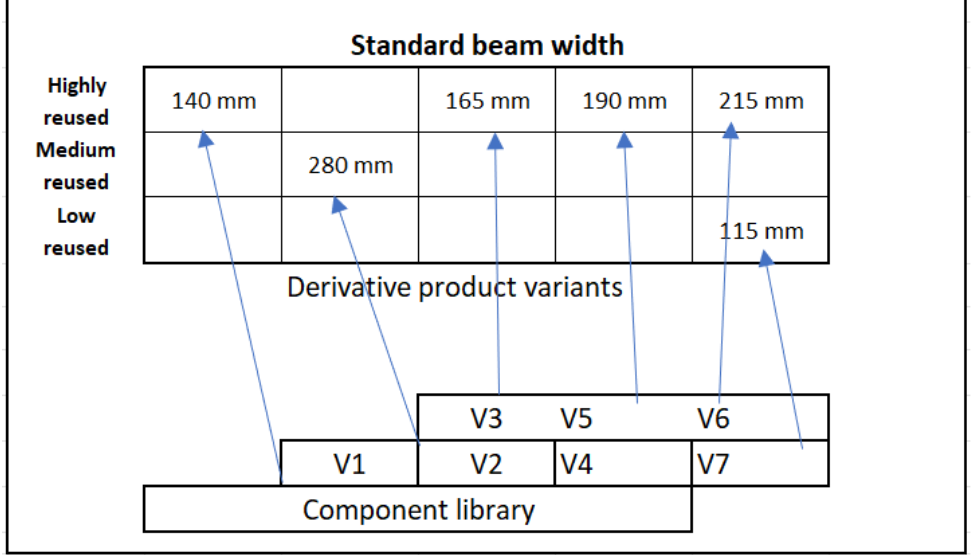
Figure 3. Frame of standard beam width.